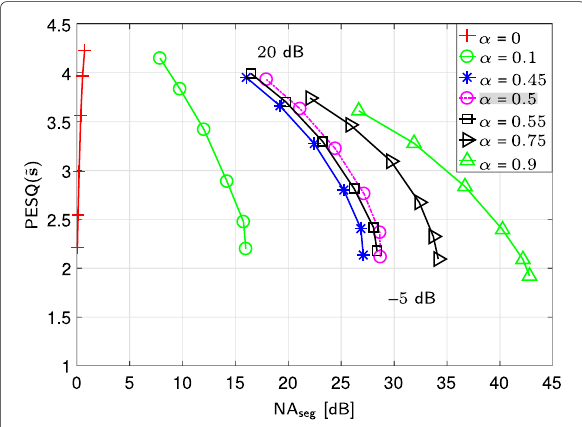
Fig. 4 Noise attenuation NA seg vs. speech component quality PESQ s for different parameters for the new 2CL (8) on 12 . 5 % of the validation set . From top to bottom, the markers are corresponding to six SNR conditions from 20 to 5 dB with a step size of 5dB. The selected setting 0.5 is gray-shaded in the